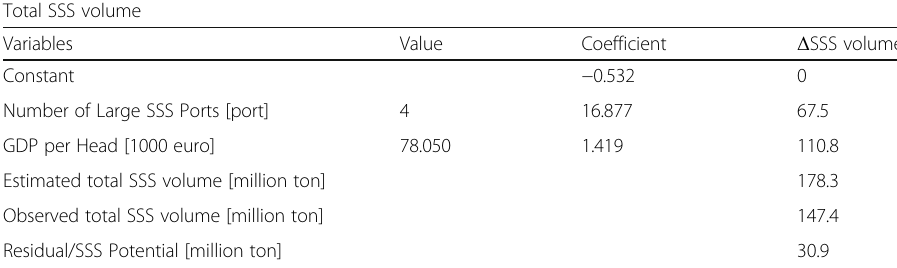
Table 9 Analysis of residual for